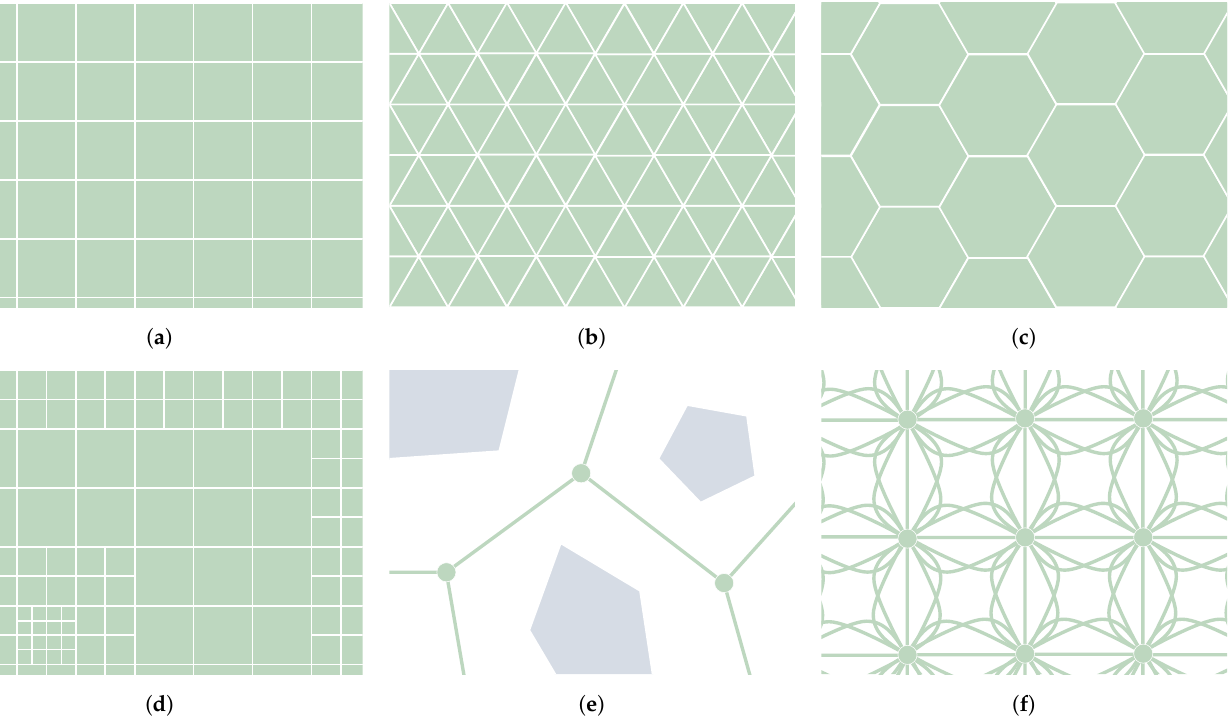
Figure 2. Different types of environment cell decomposition ( a – d ) and roadmap graphs ( e – f ). ( a ) Tessellations using squares. ( b ) Tessellations using triangles. ( c ) Tessellations using hexagons. ( d ) Irregular grid. ( e ) Voronoi roadmap. ( f ) State lattice